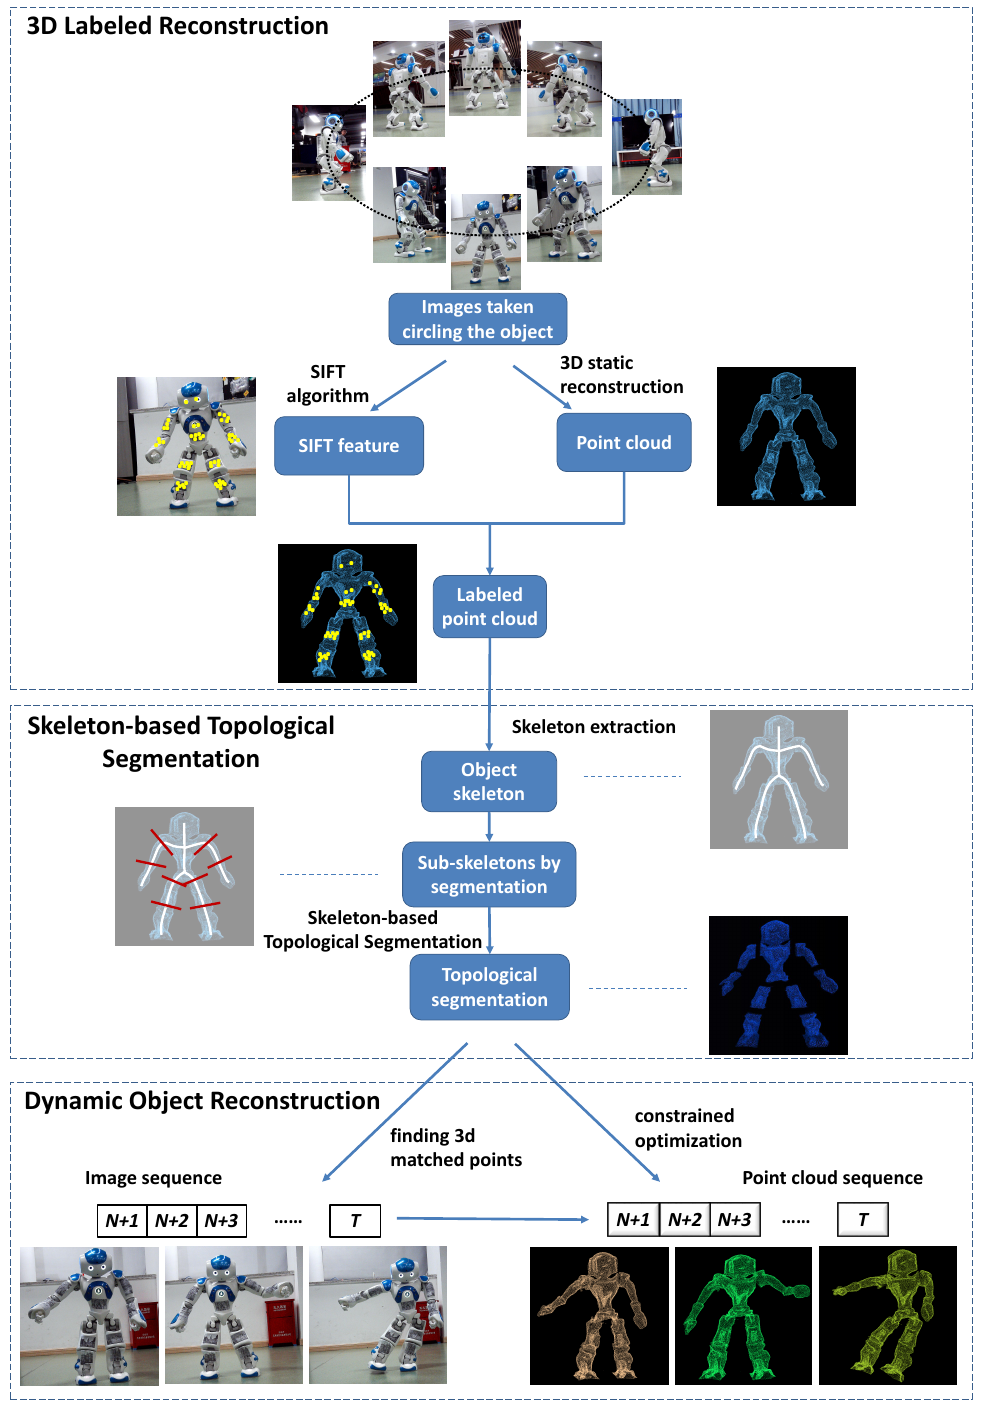
Figure 3. The framework of the proposed